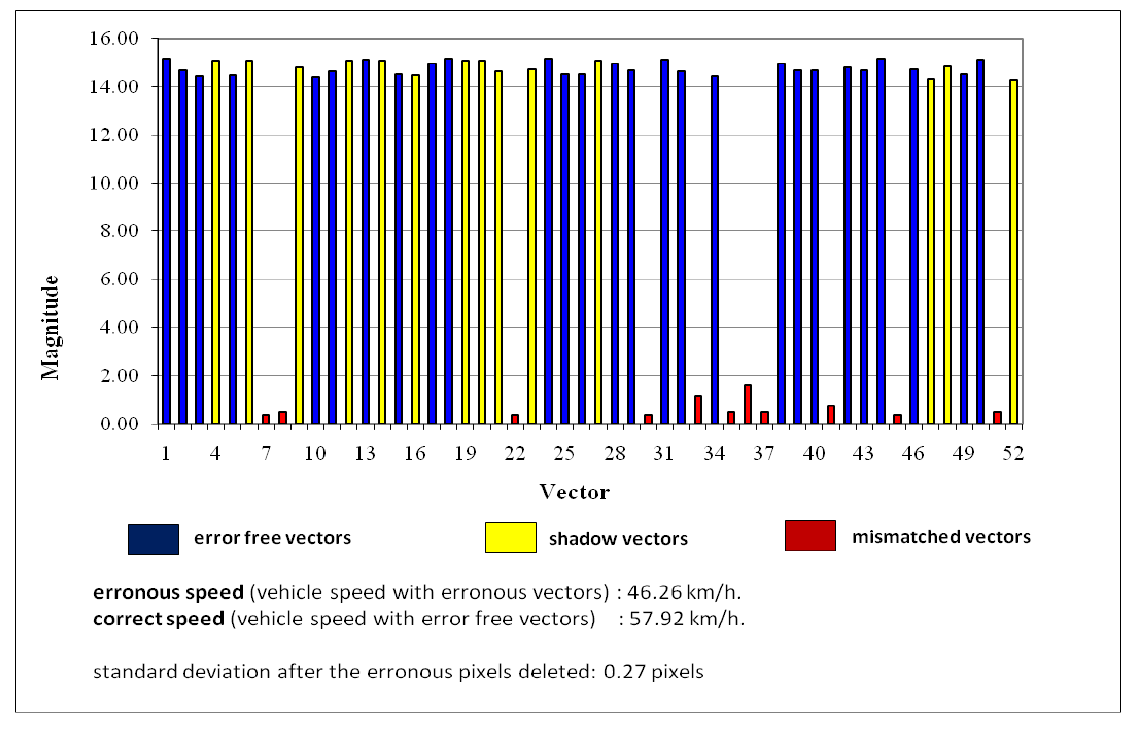
Figure 2. Graphical representation of vectors.